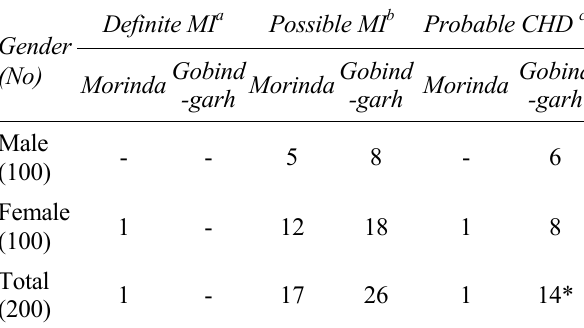
Table 9(b): Prevalence of Coronary Heart Disease (CHD) spectrum in the populations of the two study sites.